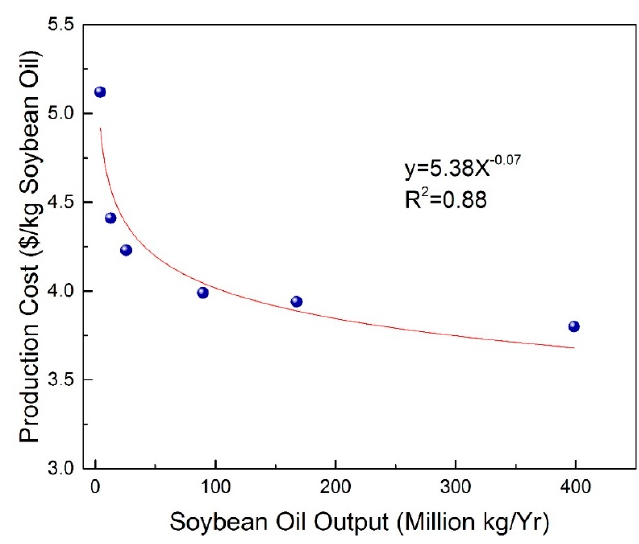
Figure 6. Non-linear relationship between net unit production cost and various scales of soybean oil production (outputs).